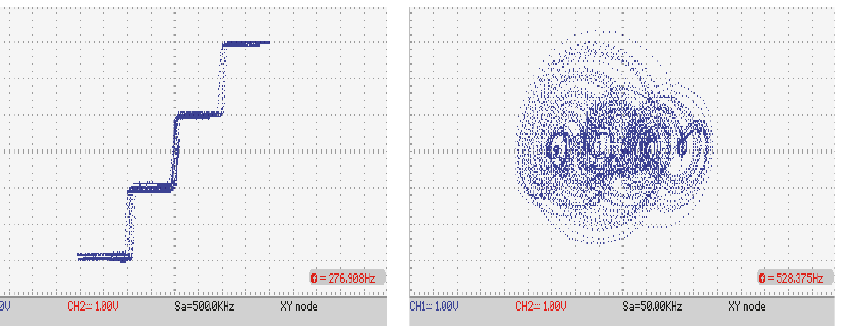
(b) Slopes: 𝑘 V = 50, 10, and 20. Ch1:1V/Div, Ch2:1V/Div